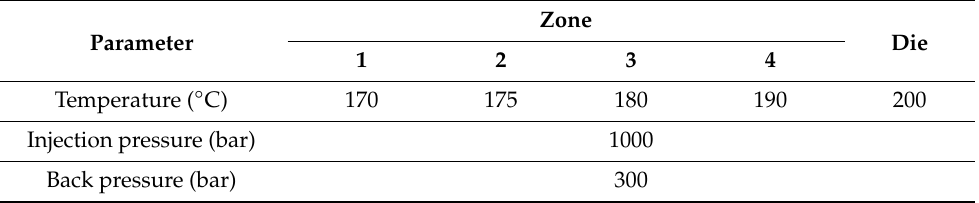
Table 4. Injection parameters used in the